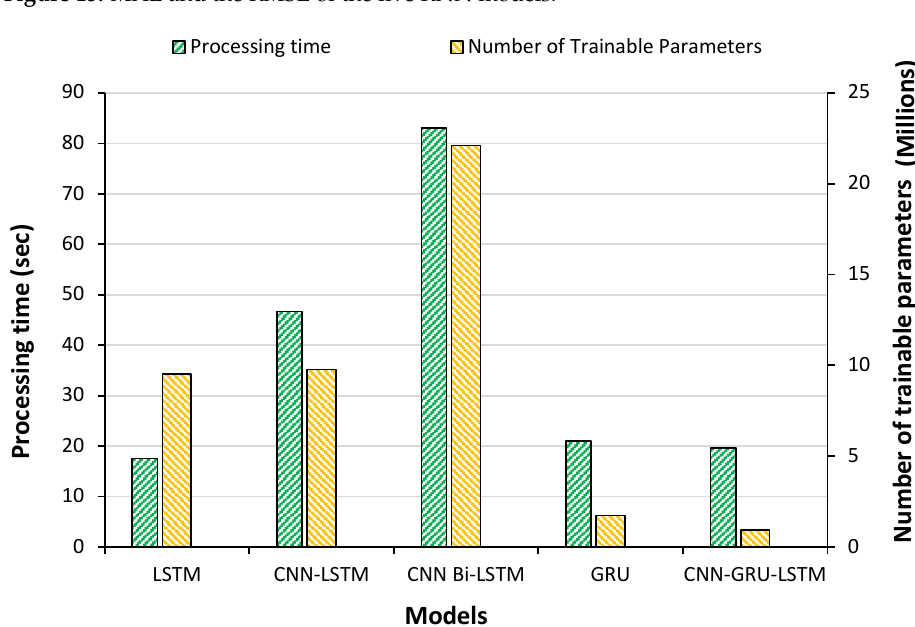
Figure 15. MAE and the RMSE of the five RNN models.